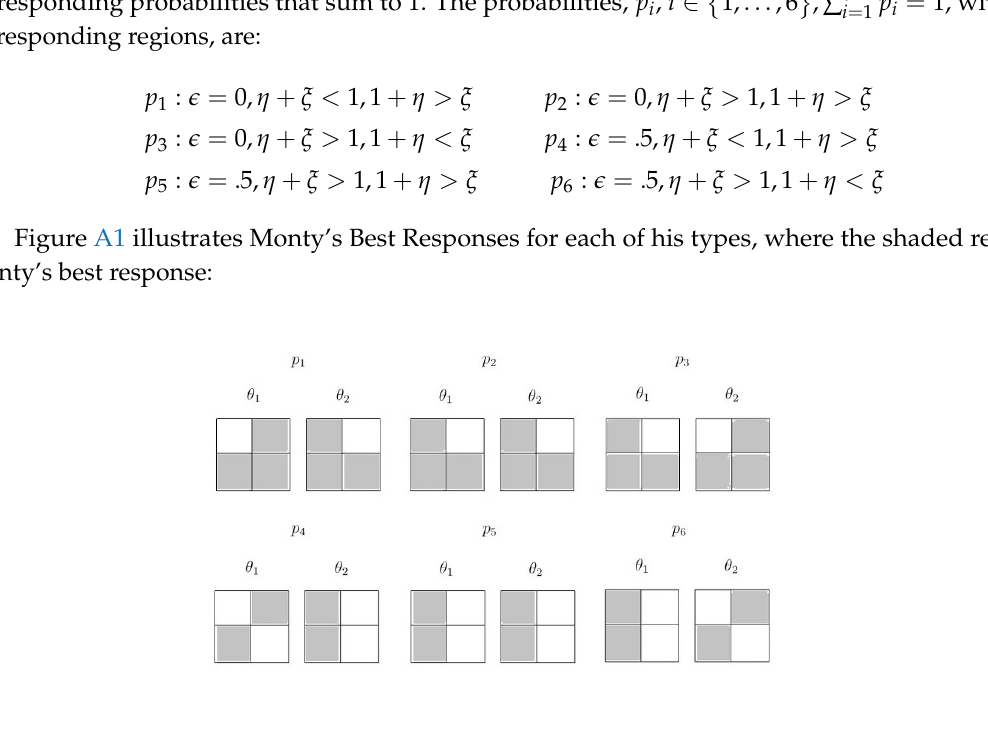
Figure A1. Best Responses of Monty